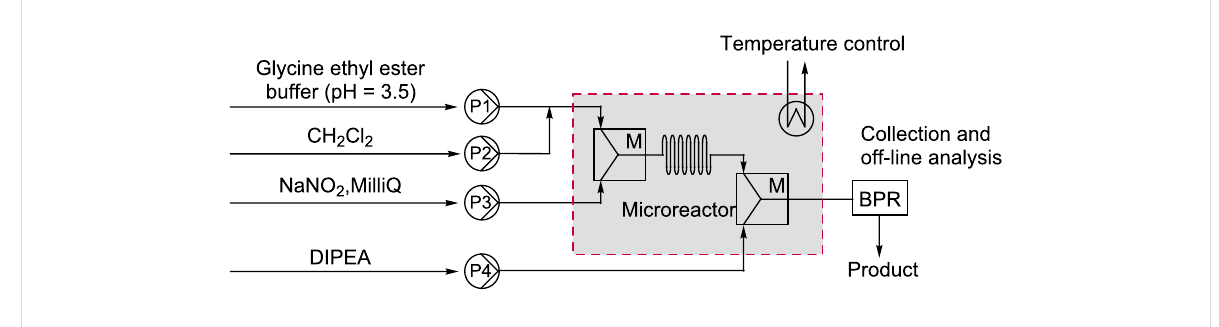
Figure 1: Schematic representation of the microreactor